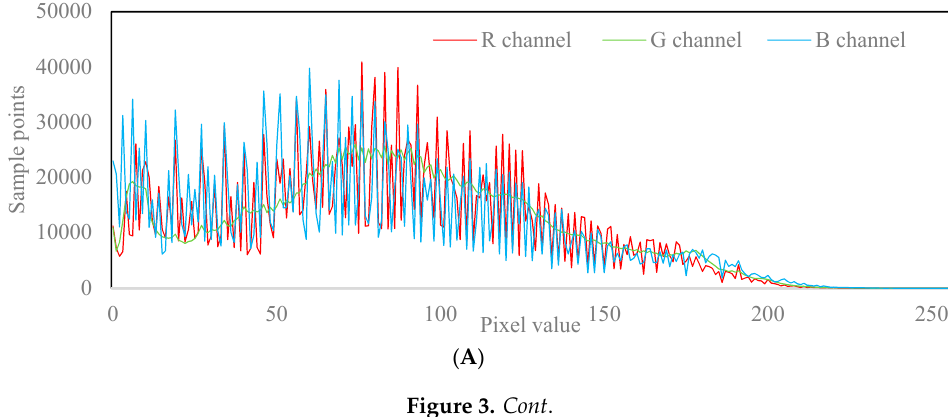
Figure 2. Experimental pictures in different color spaces. ( І ) the original image; ( A1 – A3 ) the R, G, and B channel images in the RGB color space; ( B1 – B3 ) the H, S, and V channel images in the HSV color space; ( C1 – C3 ) the Y, I, and Q channel images in the YIQ color space.